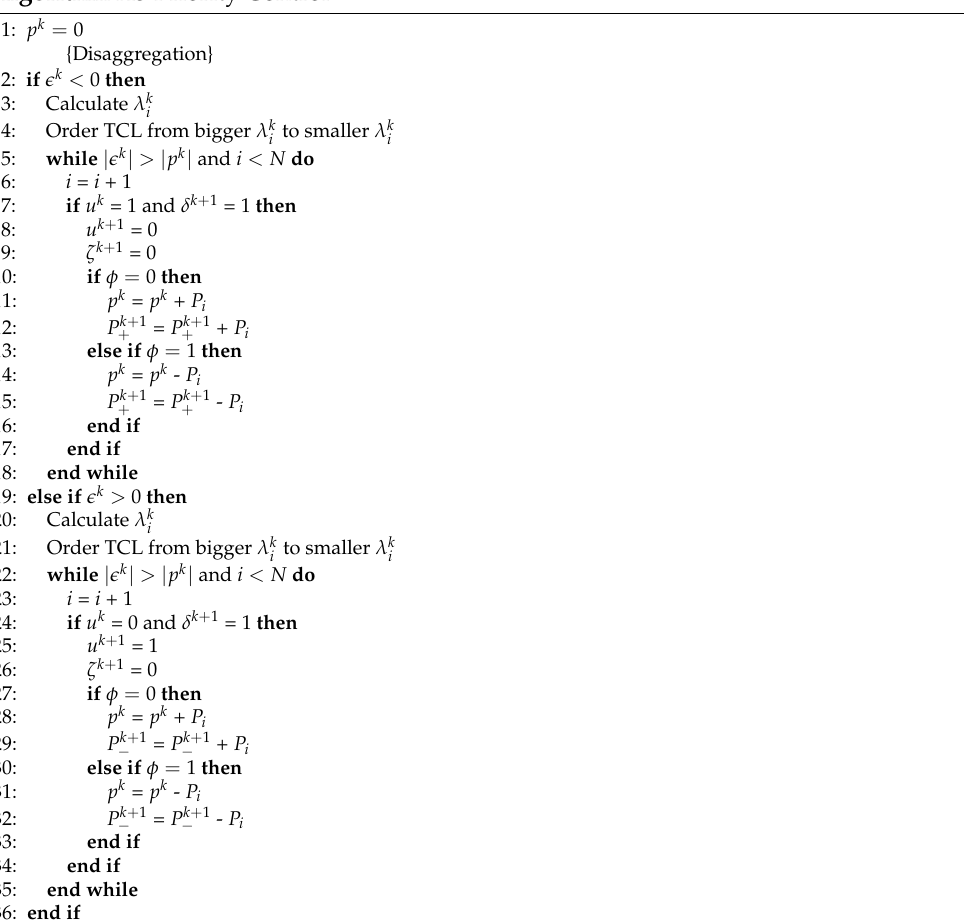
Algorithm A3 Priority